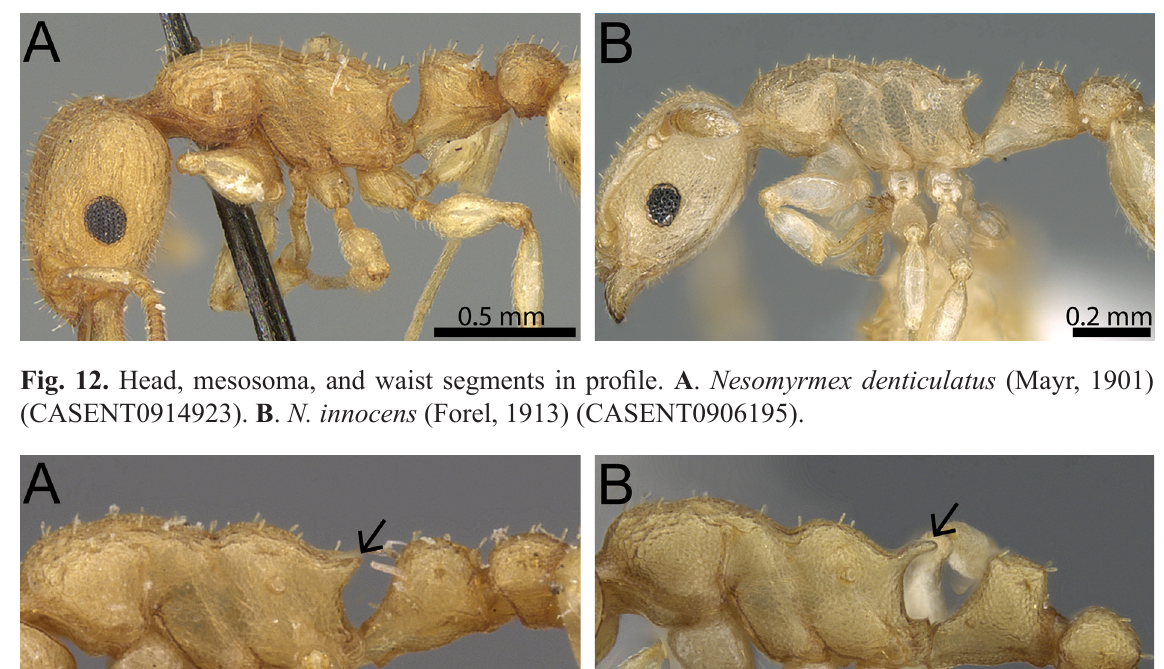
Fig. 11. Waist segments in dorsal view and mesosoma in profile. A – B . Nesomyrmex inhaca sp. nov. (CASENT0790016). C . N. denticulatus (Mayr, 1901) (CASENT0914923). D . N. denticulatus (Mayr, 1901) (CASENT0908992).